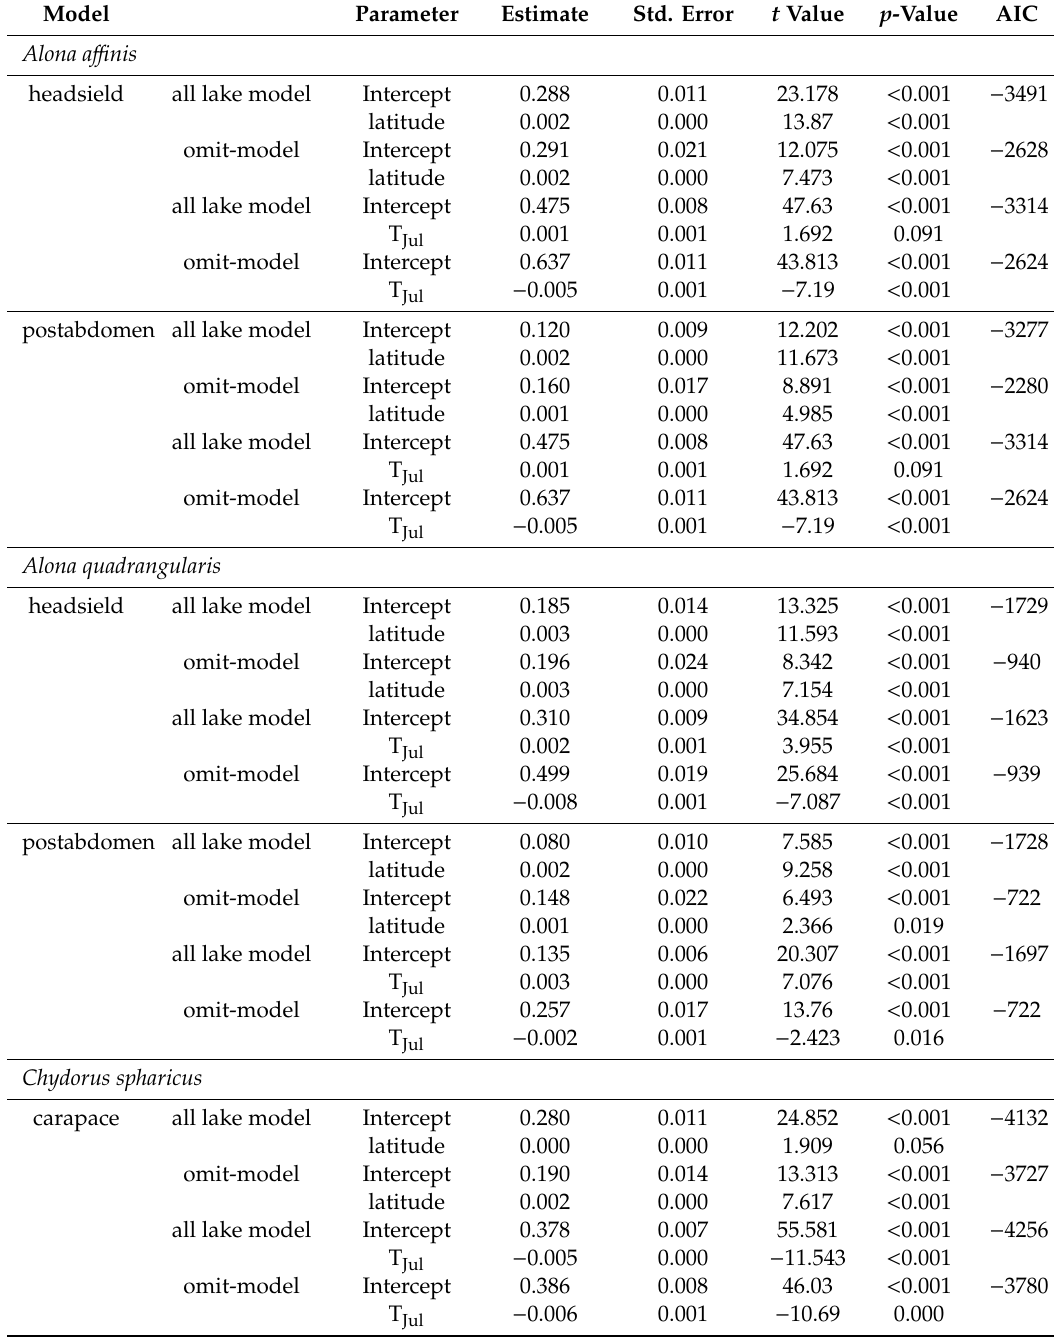
Table A3. Coe ffi cients of the generalized linear model of the relationship between latitude and length of remains (all lake model: the model contains all lake; omit-model: Southern Carpathian lakes left out the